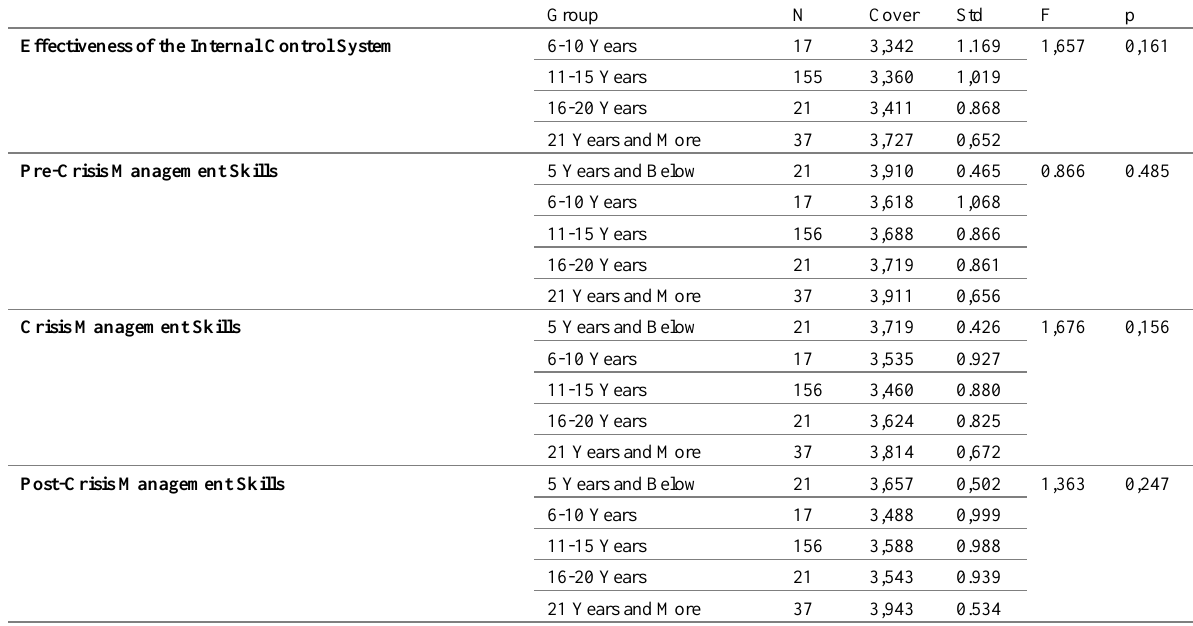
Table 11: ANOVA- The Effectiveness of the Internal Control System and Crisis Management Skill Scores of Participants Differentiation According to the Term of Duty Group N Cover Std F